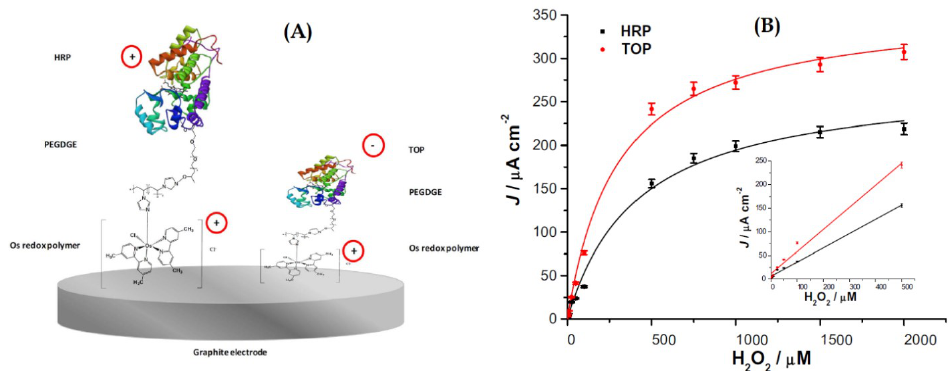
Figure 14. ( A ) Schematic representation of the biosensor based on HRP and the one based on TOP enzymes; ( B ) calibration curves for both biosensors in a FIA System with PBS buffer at pH 7 with 0.1 M KCl as carrier, and 20 µ L sample injection volume, − 0.1 V vs. Ag|AgCl (0.1 M KCl). The inset shows the linear section of the curves. With permission from